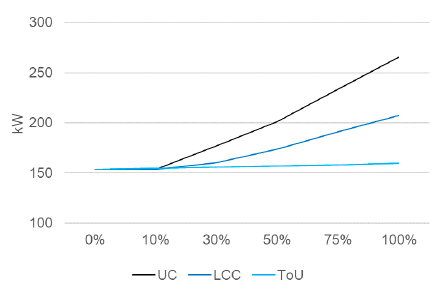
Figure 12. Development of the building’s maximum demand.